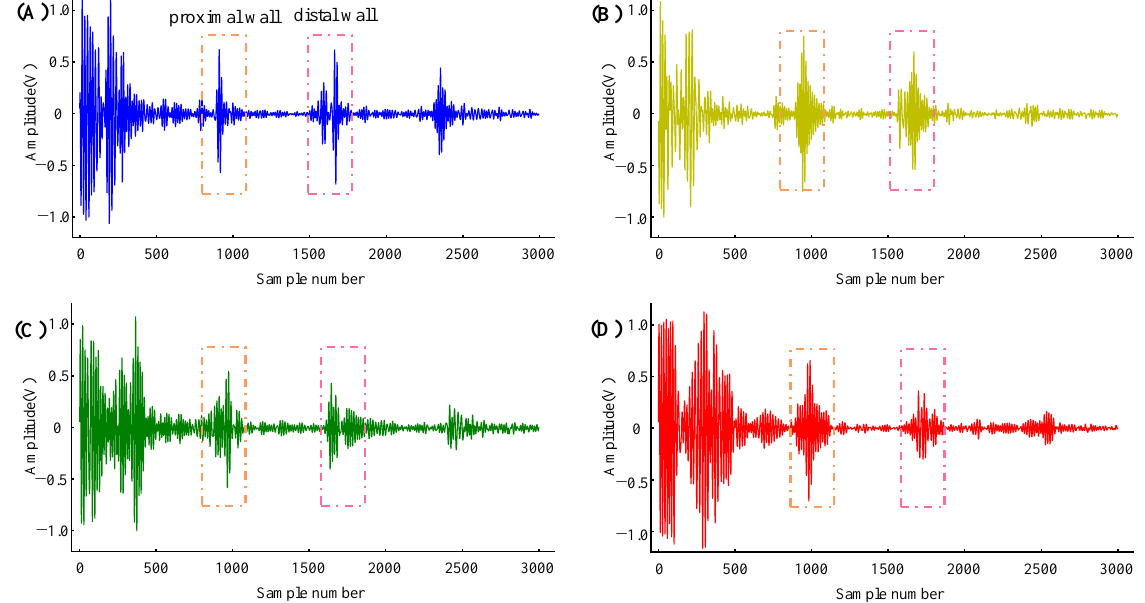
Figure 6. Echo frames captured from four arterial positions with a spacing of 10 mm. ( A – D ) are from Column 1, Column 2, Column 3, and Column 4,